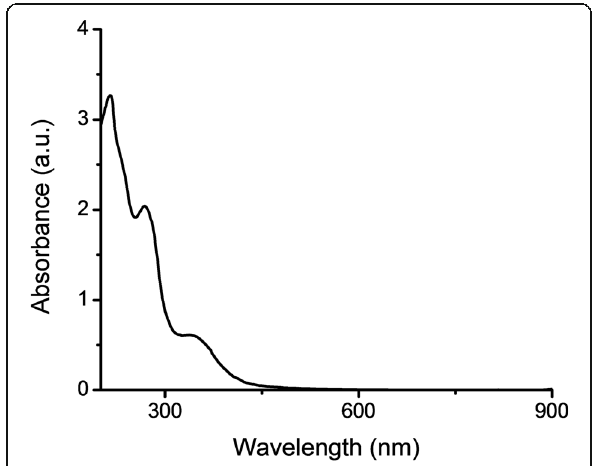
Fig. 1 UV-VIS spectrum of diluted extract (dilution factor = 100)